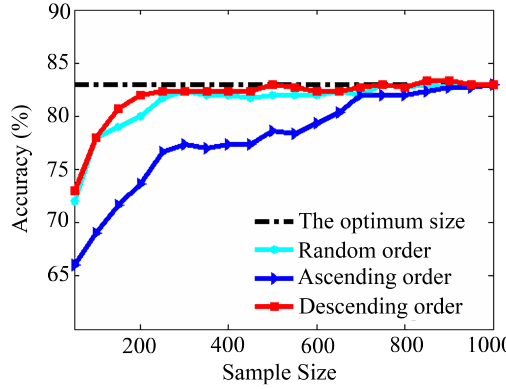
Figure 3. The accuracies as the sample size variation for different arrangement